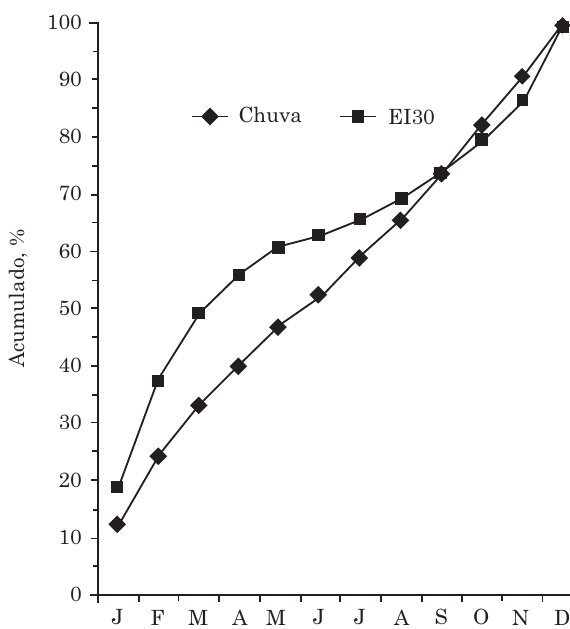
Figura 1. Distribuição acumulada da chuva e do índice de erosividade (EI 30 ) em Urussanga,